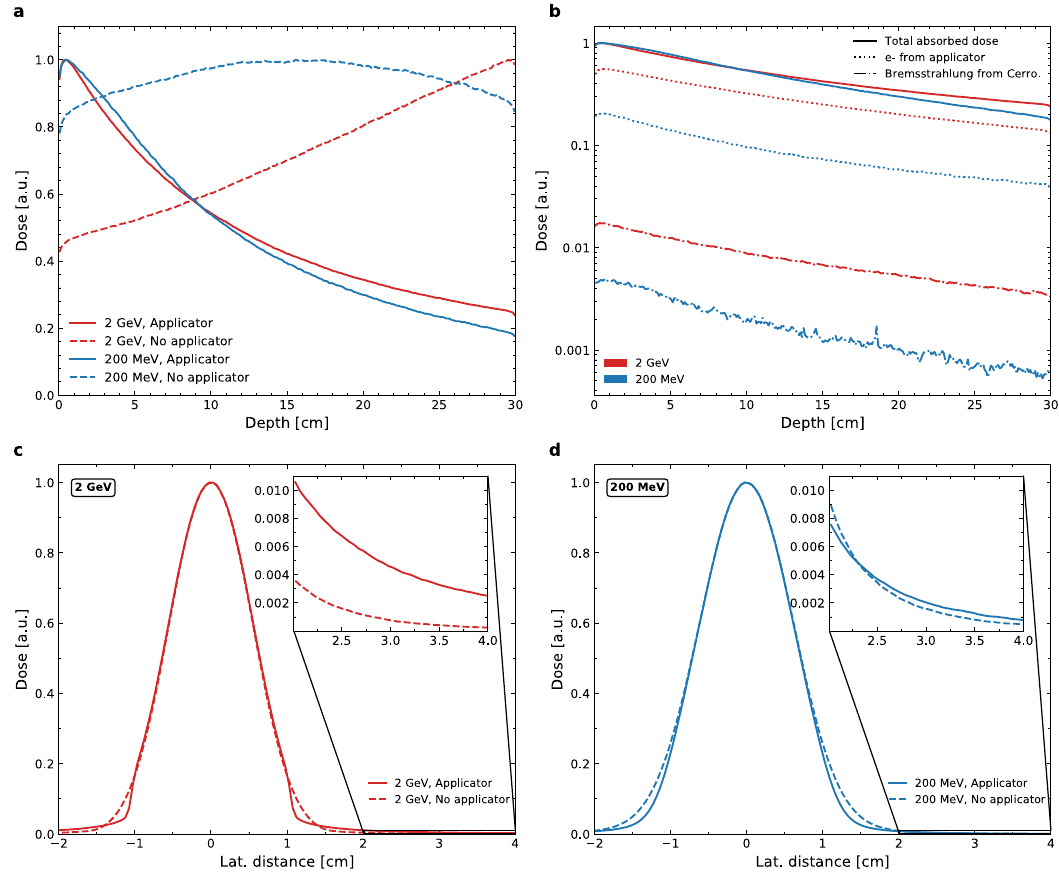
Figure 2. Distal and lateral dose profiles in the water phantom. On-axis PDD curves are displayed in the upper row of panels and were calculated using source 1 of Table 1. (a) Depicts the relative PDD curves with (solid lines) and without (dashed lines) an applicator, and for both energies (2 GeV in red and 200 MeV in blue). (b) Displays the relative contribution of electrons originating from the applicator structure or electrons with ancestors which originated in the applicator structure (dotted lines), the relative contribution of dose depositions due to the Bremsstrahlung interaction within the Cerrobend (dash-dot lines), and the total absorbed dose along the PDD (solid lines). The 2 GeV and 200 MeV beams are represented by the colours red and blue respectively. The bottom row of panels depicts the lateral dose profiles at a 10 cm depth in the water phantom, calculated using source 2 of Table 1. The solid line indicates the presence of an applicator, and the dashed line indicates its absence. (c) Contains the 2 GeV profiles, while (d) contains the 200 MeV